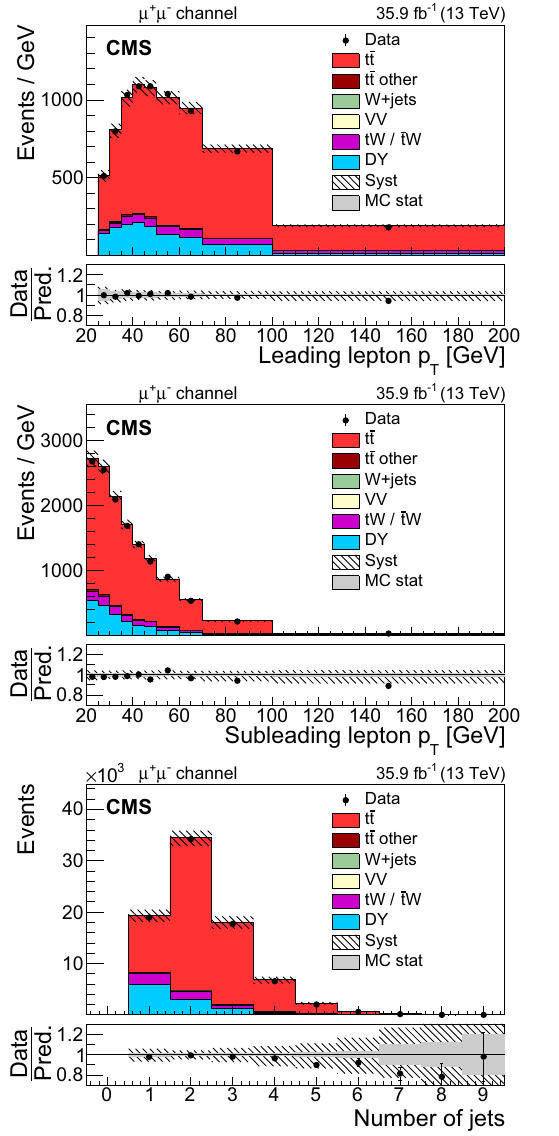
the nominal value of the parameter and to a variation by +1 and − 1 standard deviation, respectively. If a variation is only possible in one direction, a linear function is used to model the dependence on λ j